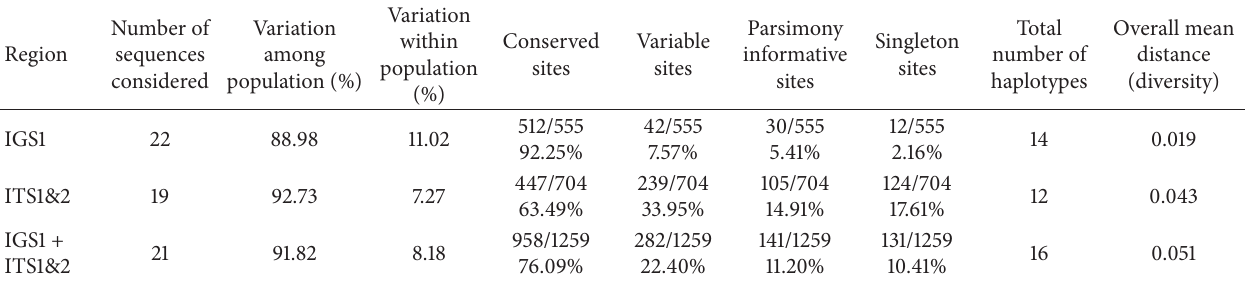
Table 4: Proposed features of IGS1, ITS, and the combination of IGS1 and ITS regions computed in the current study.